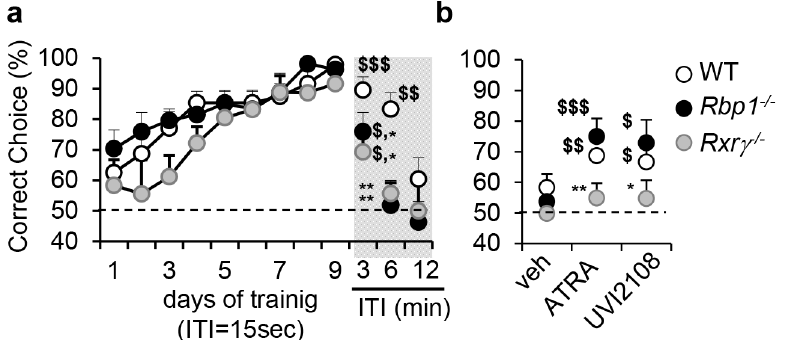
Fig 1. Compromised RXR signaling in Rbp1 -/- mice. (a) Rbp1 -/- (n = 8) and Rxr γ -/- (n = 7) mice acquired working memory DNMTP task similarly to WT (n = 8) mice (F[8,160] = 14, p < 0.001; ANOVA on repeated measures) when trained with 15 sec inter-trial intervals (ITI), but showed forgetting when tested at 3, and 6 min ITIs, which was more rapid than 12 or 18 min in WT mice (indicated in the graph as 12 min ITI). (b) RXR agonist or ATRA improved working memory performance 6hrs after treatment in Rbp1 -/- mice (n = 8) tested at 6 min ITI or WT mice (n = 8) at 12 or 18 min ITIs, but was inactive in Rxr γ -/- mice (n = 7) at ITI of 6 min. Compromised RXR signalling in Rbp1 -/- was further supported in spontaneous alternation task, a distinct test for working memory (S1 Fig). Statistical differences identified with PLSD Fischer test were indicated as: * , p < 0.05; ** , p < 0.01 as compared to WT controls in respective groups; $, p < 0.05; $$, p < 0.01; $$$, p < 0.001 in comparison with 50% of chance